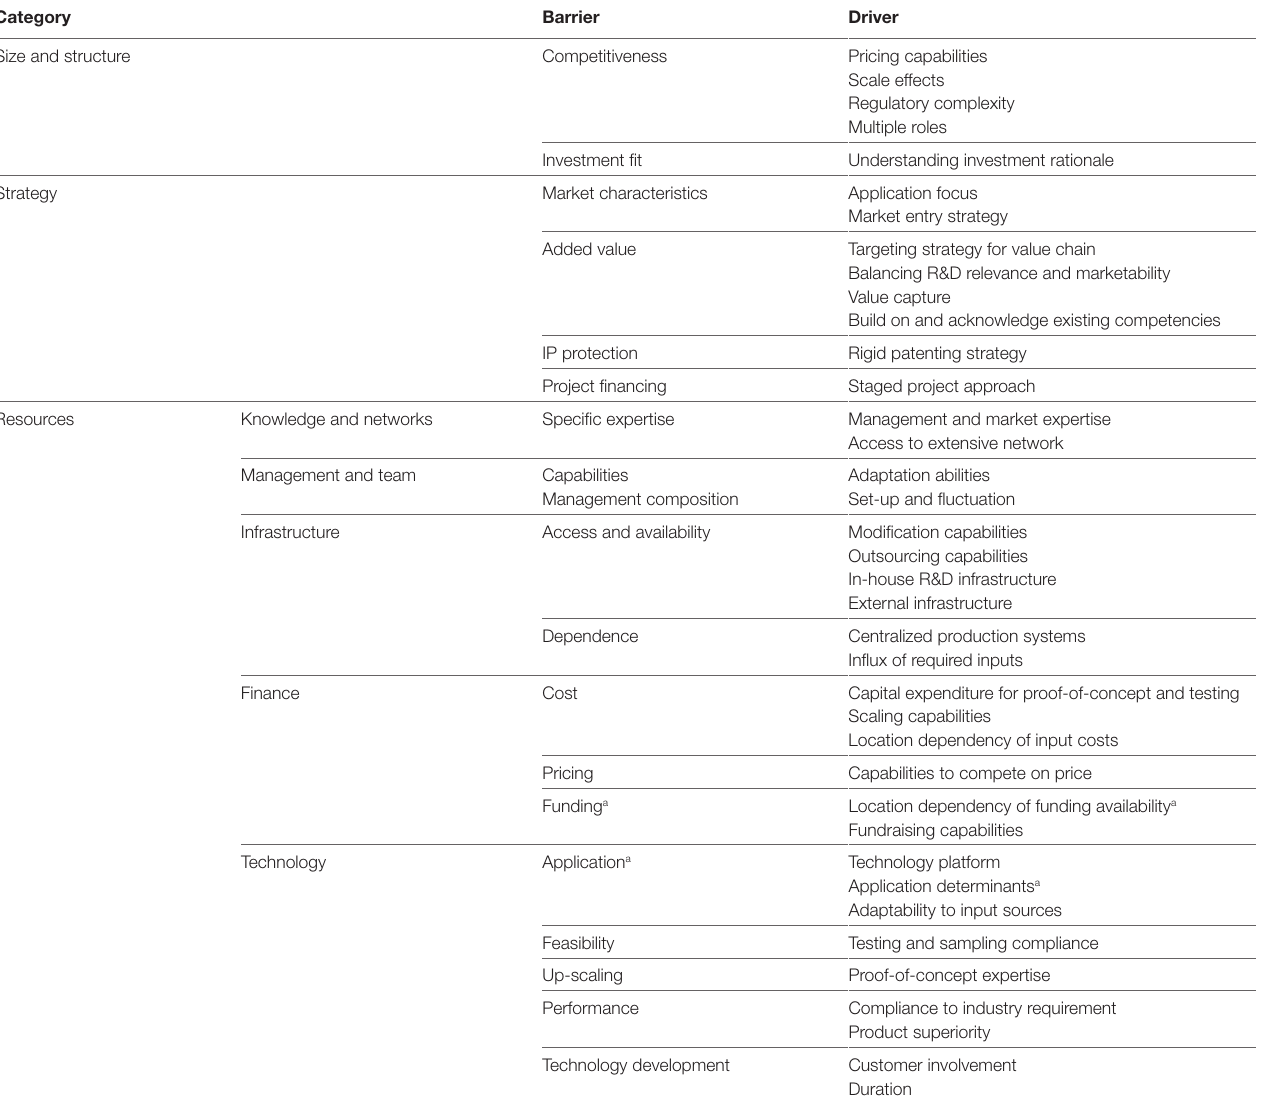
TaBle 3 | Overview of internal organization barriers and